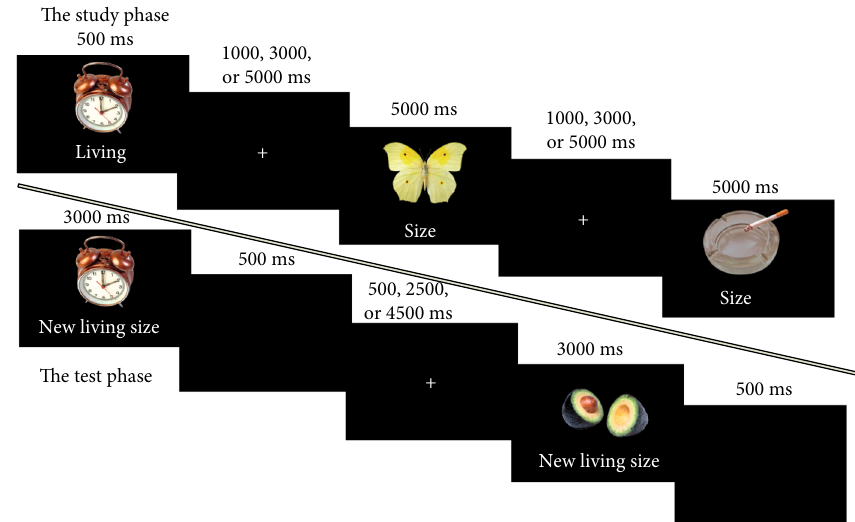
Figure 1: Schematic description of the study and test phases of the